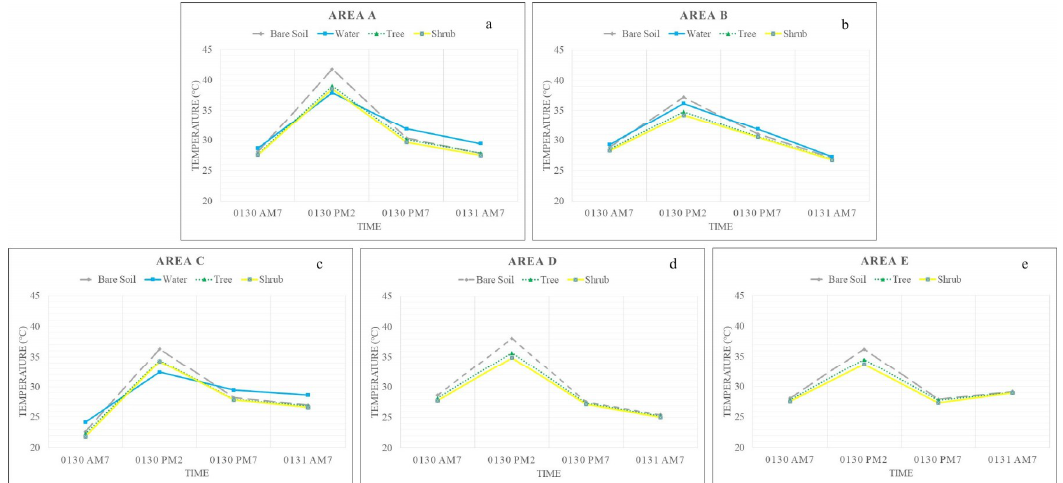
Figure 5. Temporal characteristics of temperature trends for each land cover type in Areas A–E. The small letters in the upper-right corners indicate that the location is different from all other locations (computed by the Tukey honesty significance difference (HSD) method ( p < 0.05)).